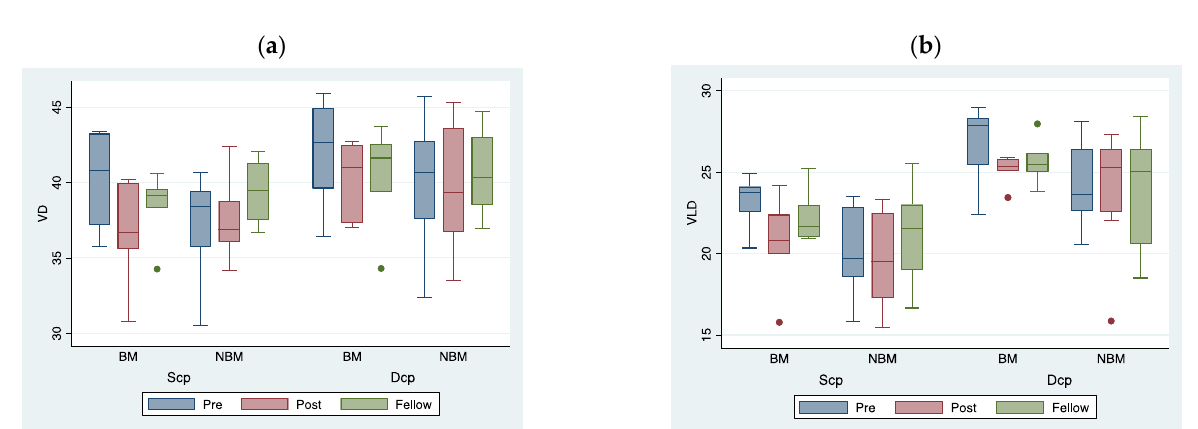
Figure 4. Boxplot showing distribution of VD ( a ) and VLD ( b ) in both DCP and SCP after, before surgery and fellow eye results for the BM and NBM groups. Boxes represent interquartile range, whiskers represent variability and horizontal bars represent the median value.